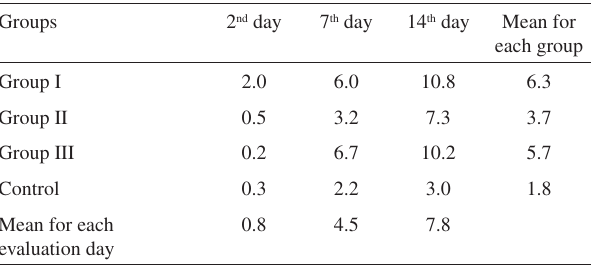
Table 2 - BBB functional evaluations on the second,